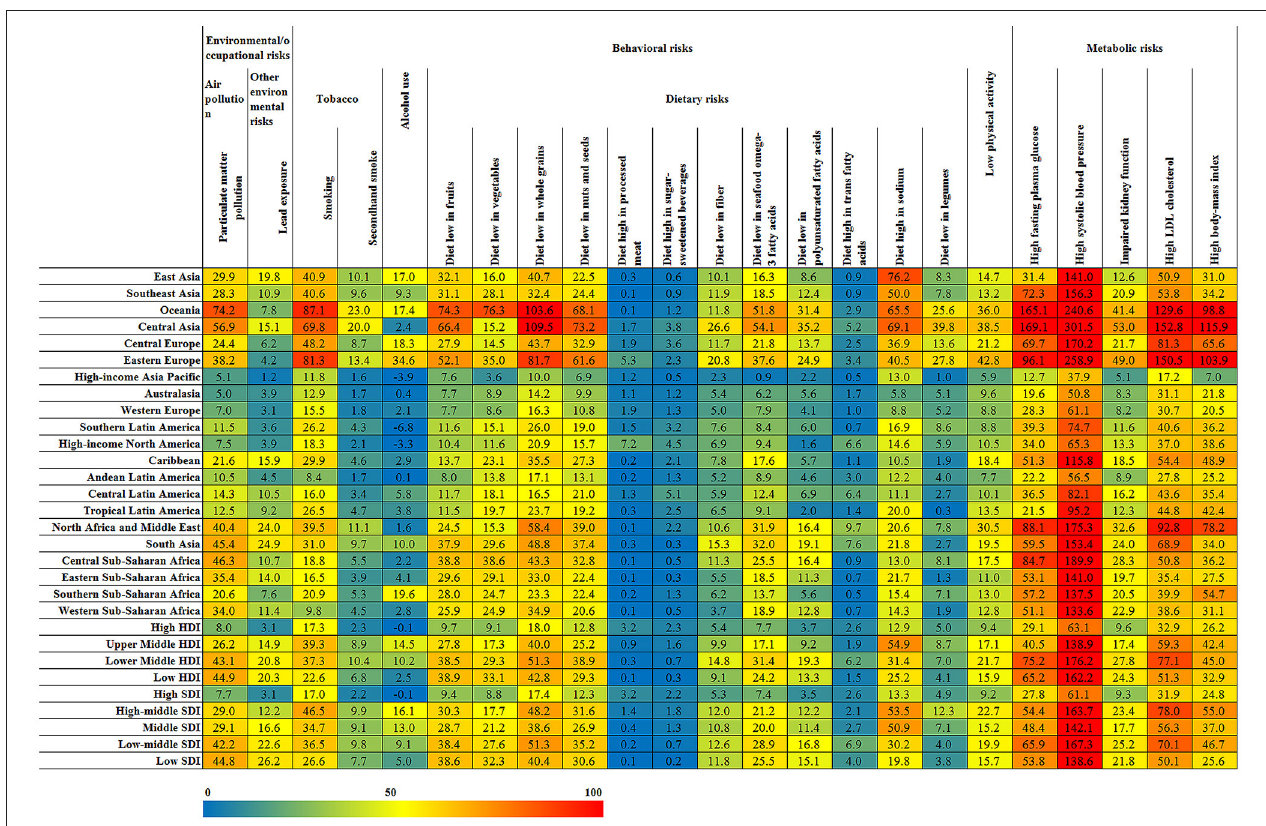
FIGURE 10 | The ASDRs of CVD induced by different risk factors in different